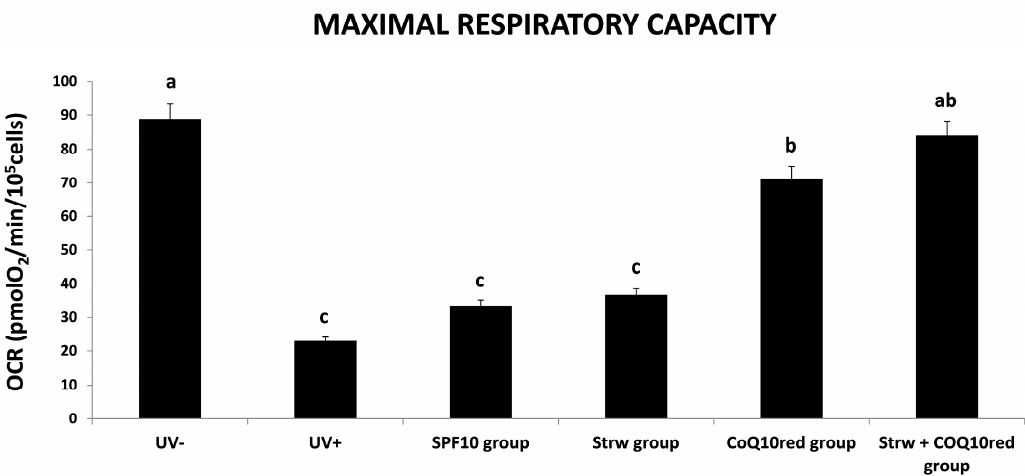
Figure 5. Maximal respiratory capacity value of human dermal fibroblast (HDF) cells irradiated with ultraviolet A (UVA, 275 kJ/m 2 ) radiation (UV+) or not irradiated (UV − ), after 1 h of exposure HDF were screened with different formulations as explained in the text. Data are expressed as mean values ± standard deviation (SD). Columns with different superscript letters are significantly different ( p ˂ 0.05).